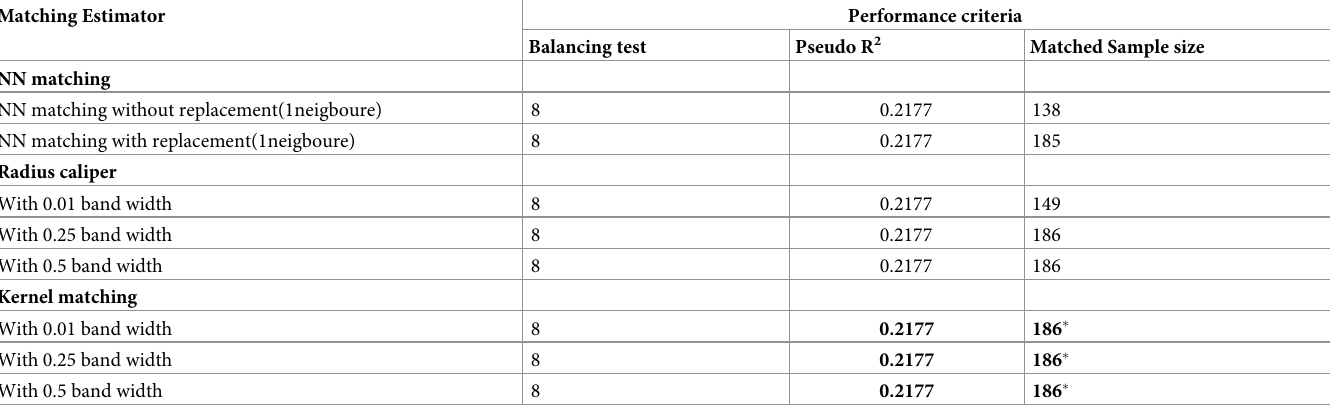
non-participant groups, both before and after matching. The p-value is based on a regression of the variable on the participant indicator. Before matching this is an un-weighted regression on the whole sample while after matching the regression is weighted using the matching weight and is based on the support sample. According to the p-value of individual tests, simi- larities in the mean values between treatment and control groups in this matching estimator, relatively all of the variables have lower p-value (insignificant). This shows kernel bandwidth matching is preferred as the best estimator of the average treatment effect. Consequently, only the outcome of this estimator is used to meet the study objectives of estimating the impacts of PSNP on the food security of households(Table 8). Table 9 indicates that the value of Pseudo − R 2 was very low. This low Pseudo − R 2 value and the insignificant likelihood ratio test indicate that the PSNP participant and nonparticipant household had the same distribution in the covariates after matching. These results indicate that the matching procedure can balance the characteristics in the treated and the matched Table 7. Performance of matching estimators using three